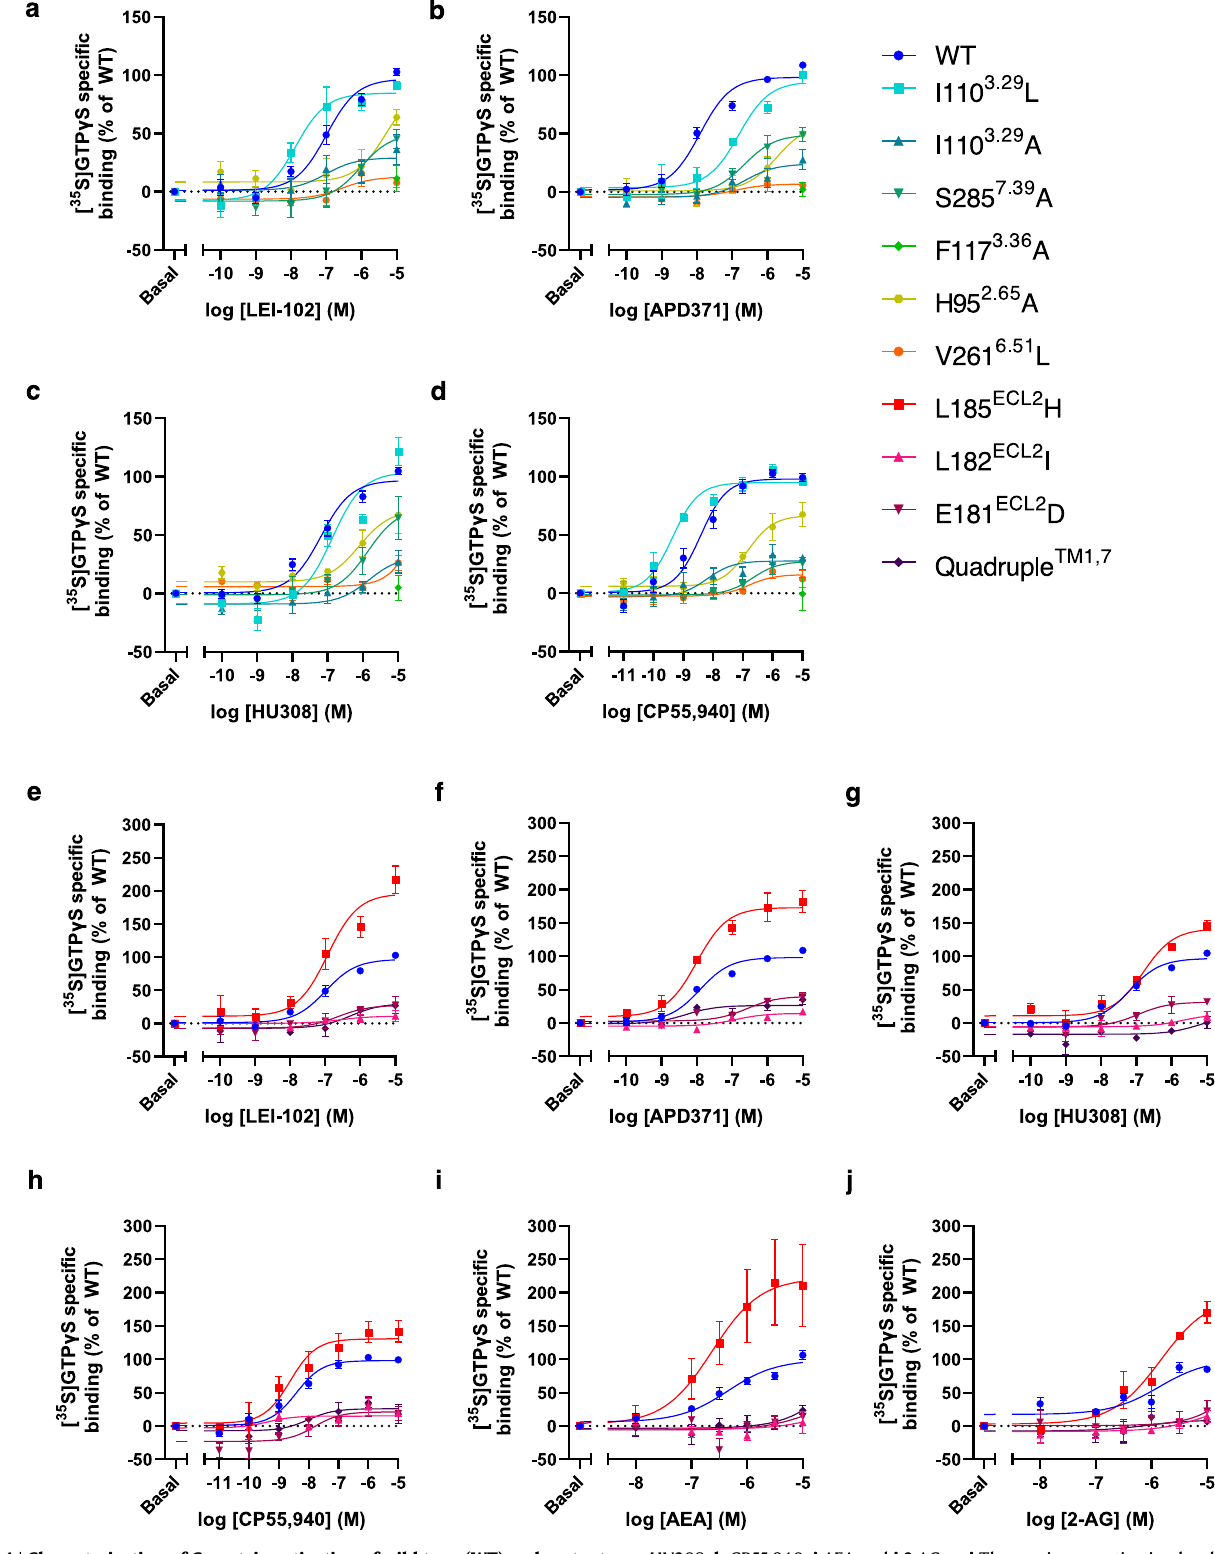
Fig. 4 | Characterization of G protein activation of wild type (WT) and mutant CB 2 R by synthetic agonists and endocannabinoids. Dose-response curves for G protein activation of WT and mutants that are located in the CB 2 R binding pocket by a LEI-102, b APD371, c HU308, and d CP55,940. e – j Dose response curves for G protein activation of WT and mutants that are proposed to be involved in ligand entry of CB 2 R via either the ECL2 or membrane access by e LEI-102, f APD371,